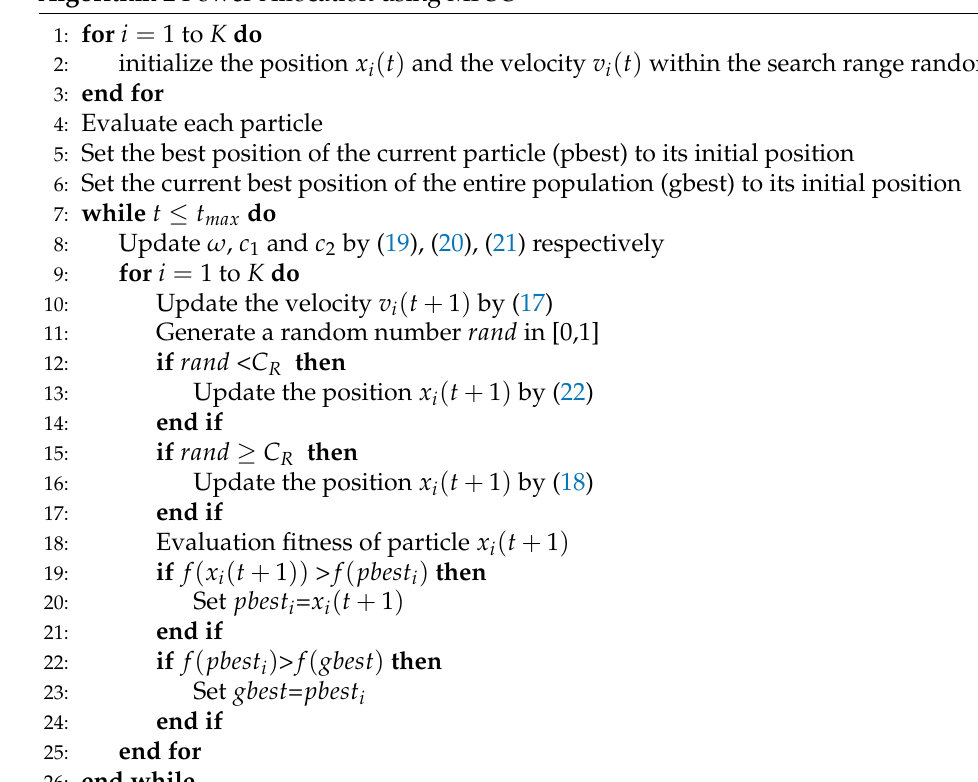
Algorithm 2 Power Allocation using